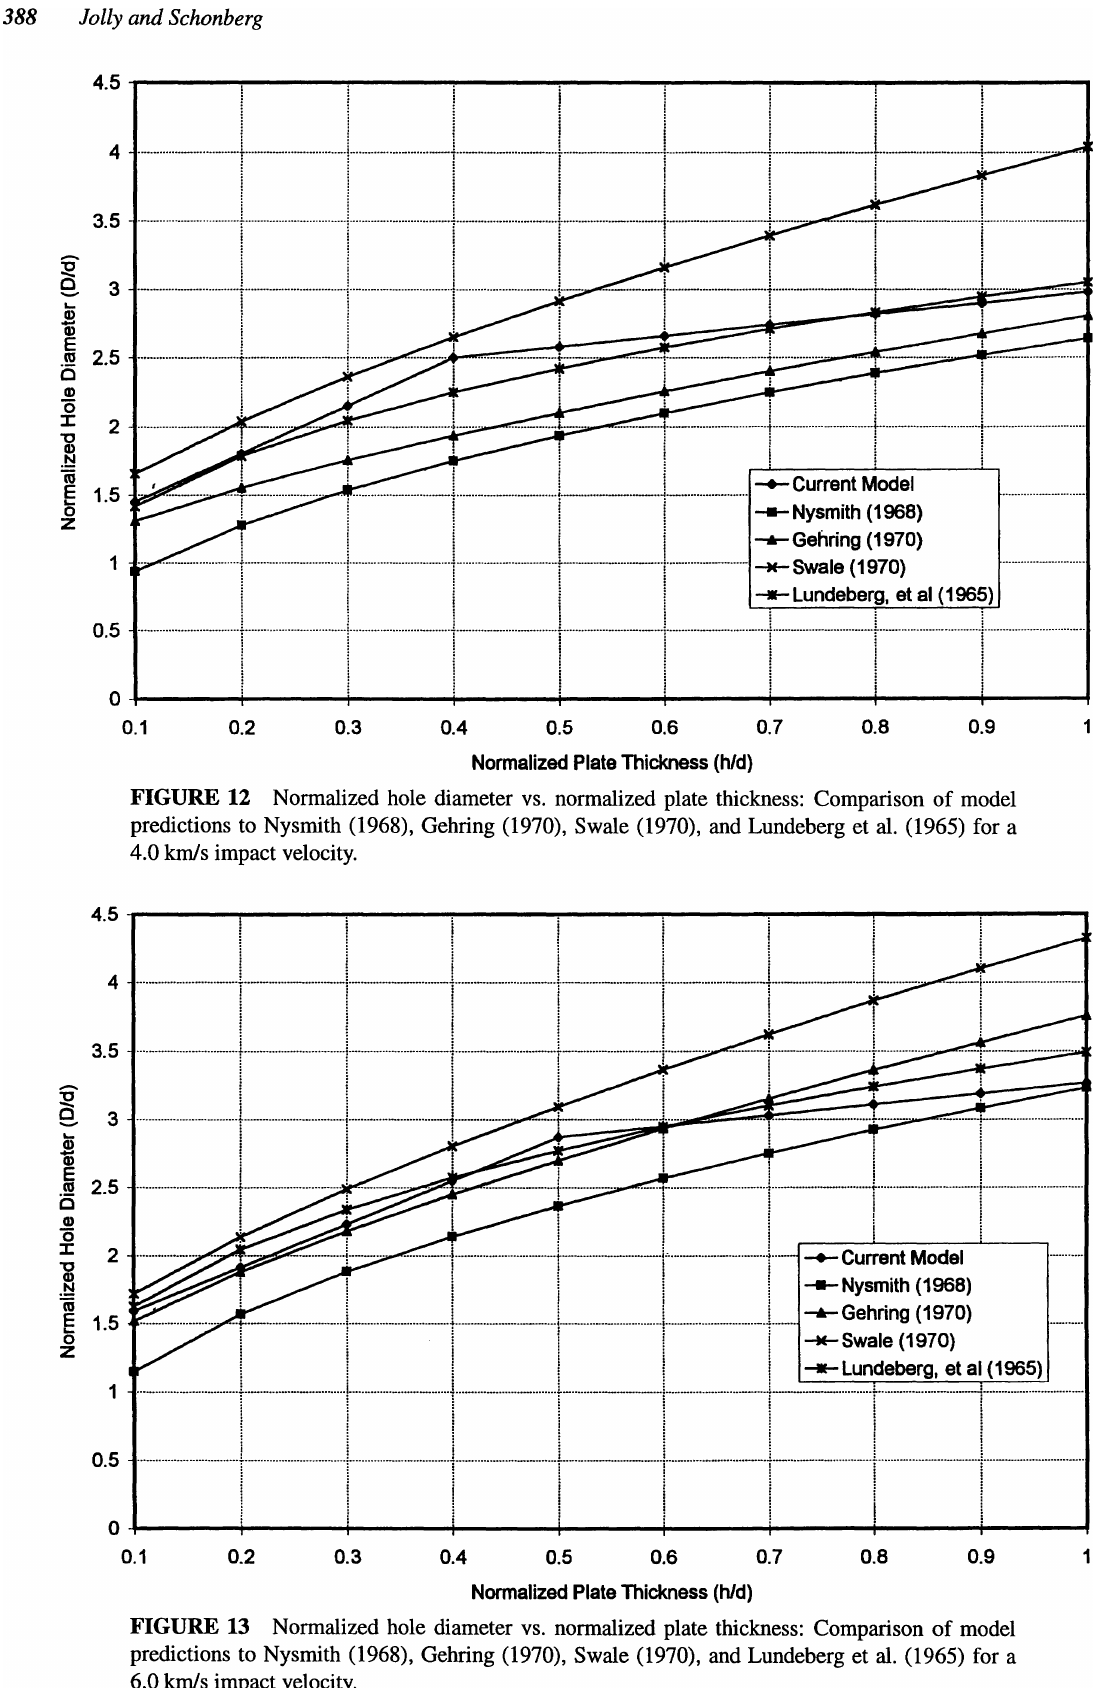
FIGURE 13 Normalized hole diameter vs. normalized plate thickness: Comparison of model predictions to Nysmith (1968), Gehring (1970), Swale (1970), and Lundeberg et al. (1965) for a 6.0 kmls impact